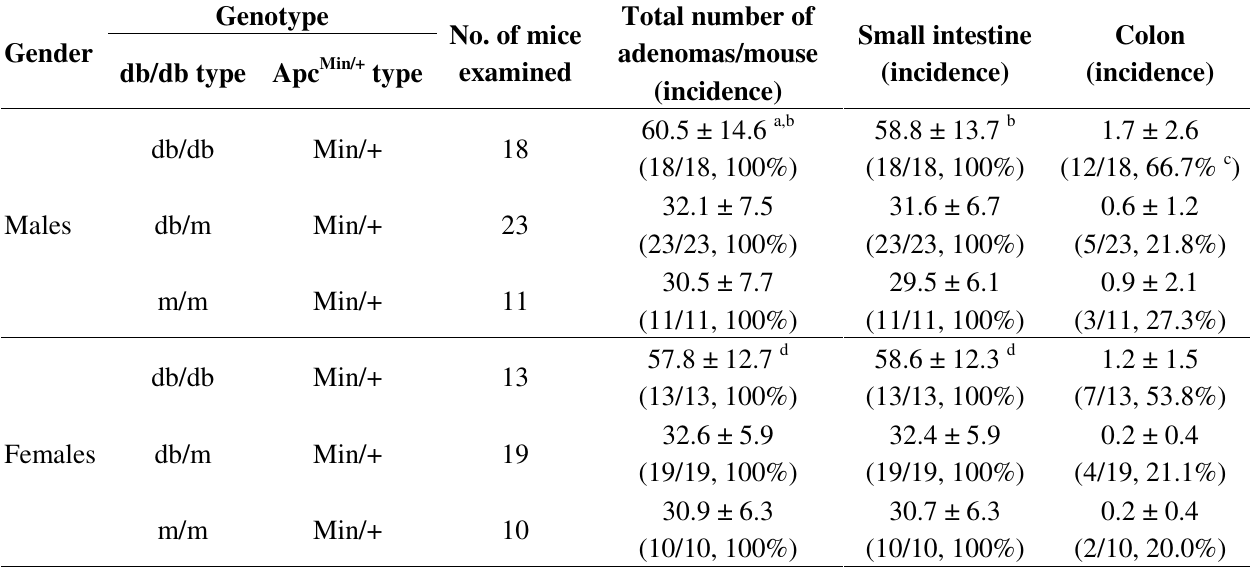
Table 3. Multiplicity (no. of tumors/mouse) and incidence of intestinal tumors (adenomas) of mice at 15 weeks of age.